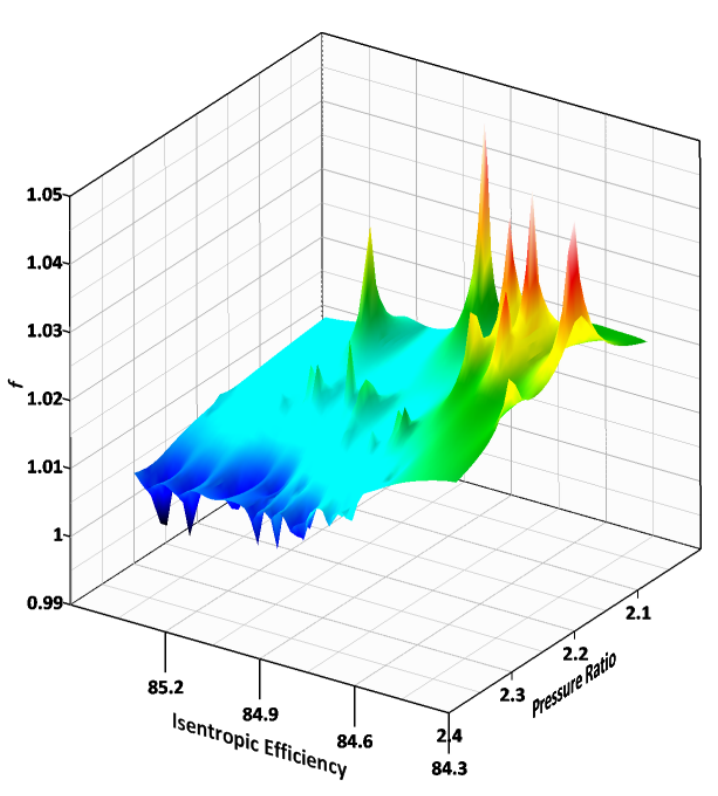
Figure 16. All design point performances and the values of f